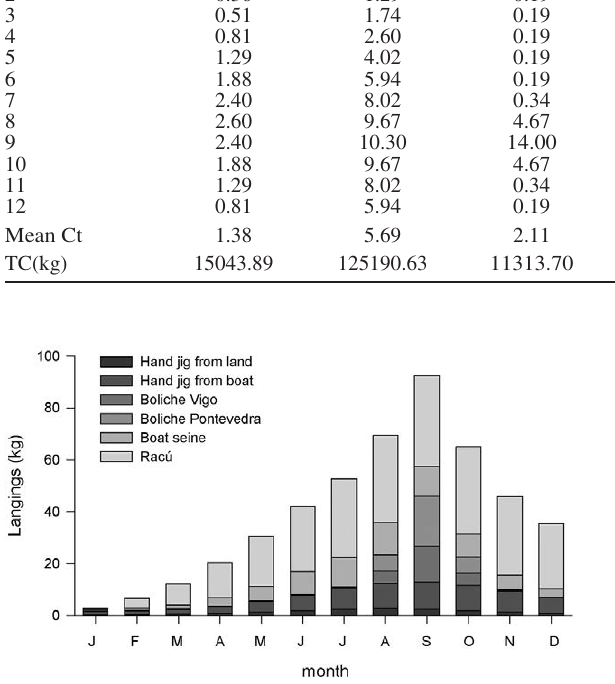
Fig. 7. – Loligo vulgaris . Monthly Ct (kg per trip or CPUE) of the set of fishing gears that operated in the Ría de Vigo and adjacent areas during the period 2011-2015 according to the Gómez-Muñoz model.